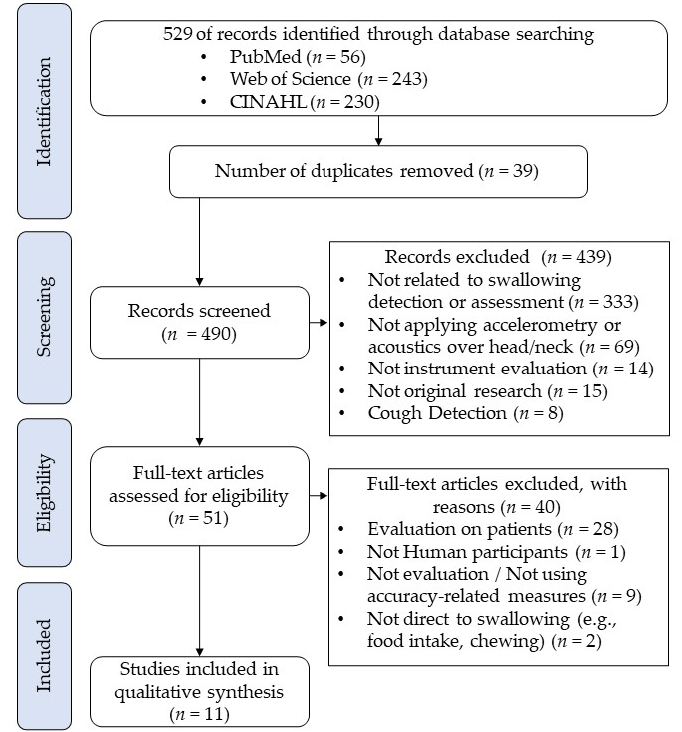
Figure 1. PRISMA flowchart of systematic search and screening.